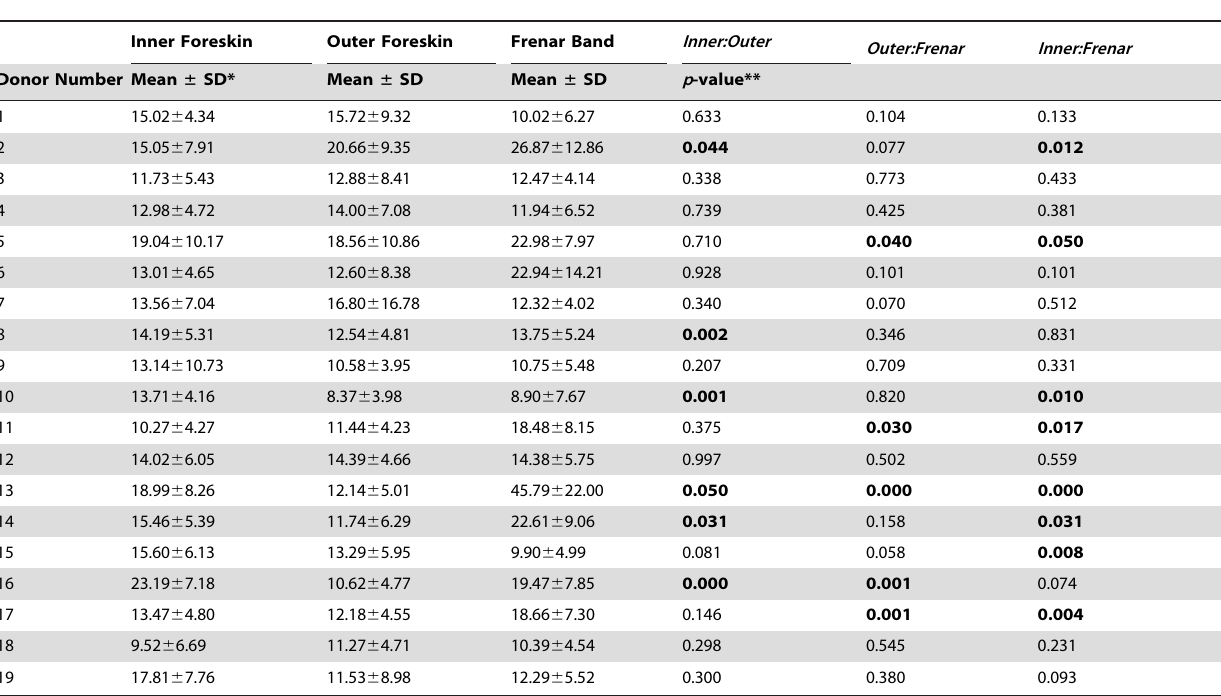
Table 2. Individual keratin thickness measurements by anatomic foreskin region.